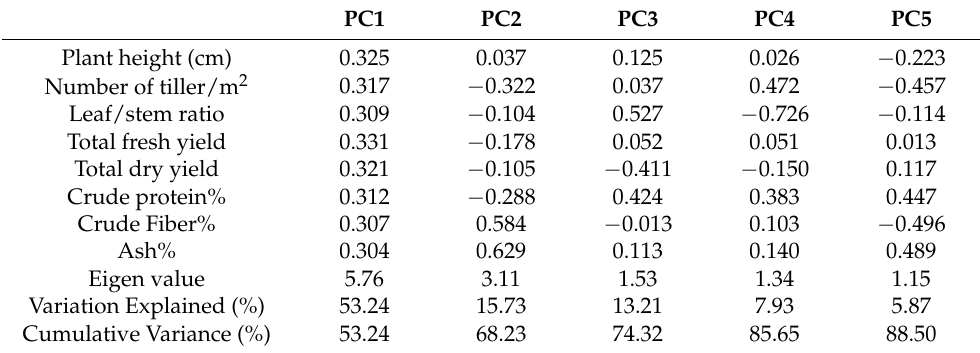
Table 9. Principal component analysis of measured characteristics in twenty-one genotypes of